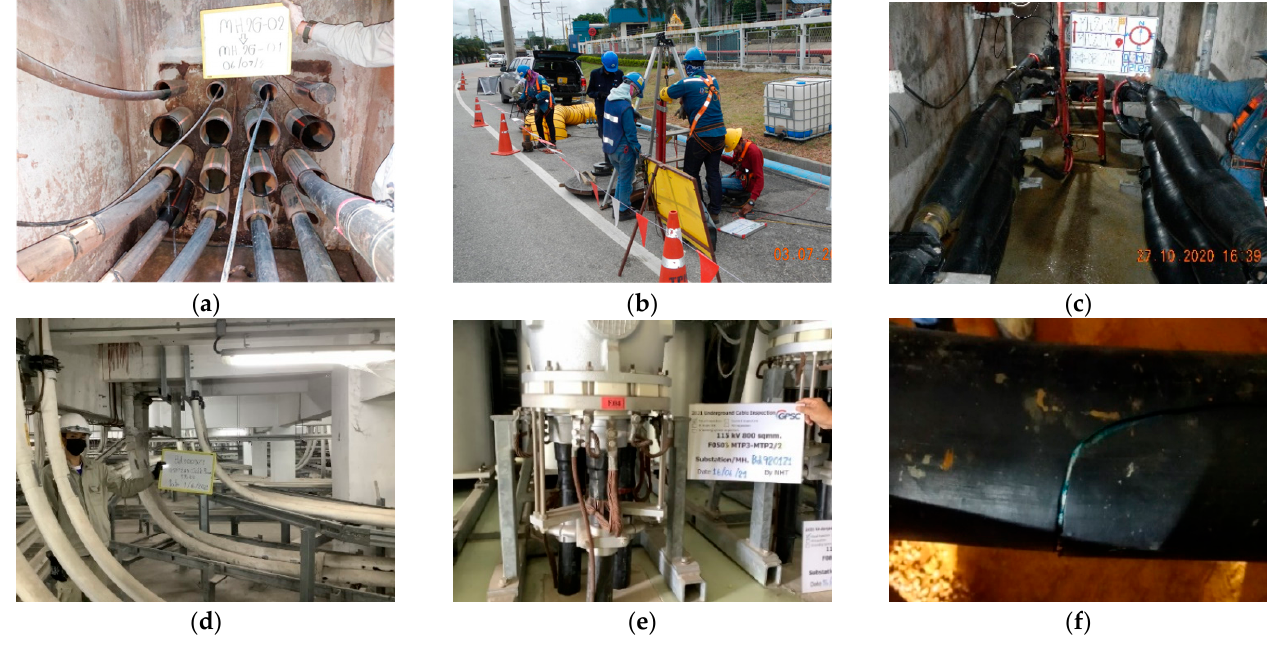
Figure 2. Example working environment of underground cable systems: ( a ) cable laying through duct bank; ( b ) cable laying across the road; ( c ) joints of cables; ( d ) cable laying under the building; ( e ) plug-in GIS cable terminations; ( f ) cracked cable jacket. Table 2. Operating criteria for OF calculation [14,24,25]. Criteria Considering Item Normal Satisfactory Risk service age (yrs.)